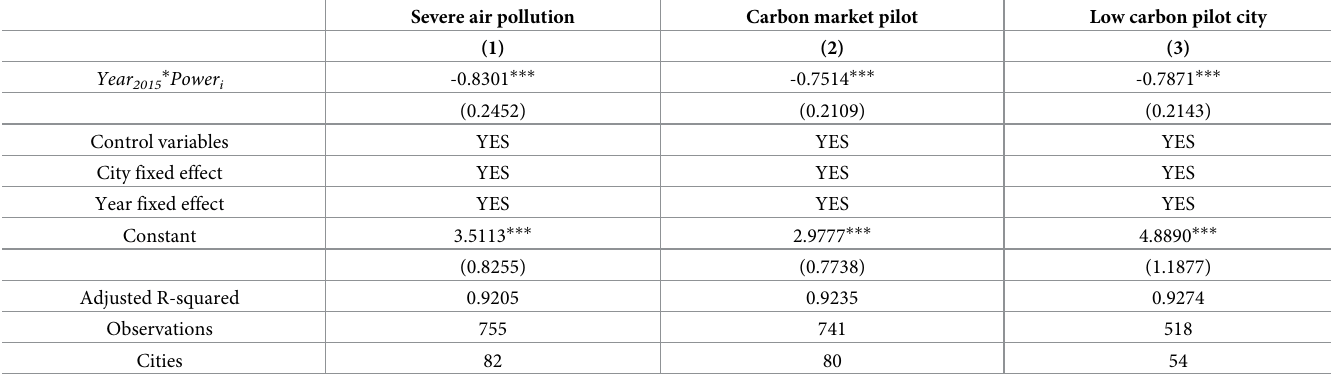
Table 7. Elimination of interference from environmental